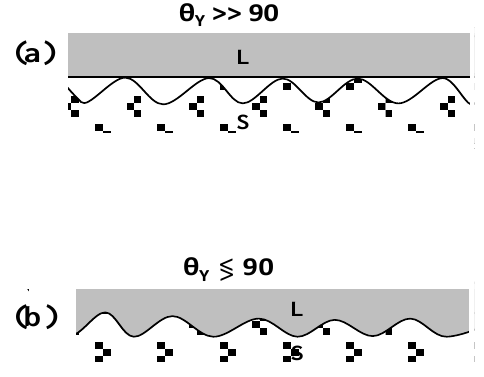
Figure 3. Microscopic configuration at solid/liquid interfaces: ( a ) For θ Y >> 90°, at microscopic scale, the liquid contacts the rough surface of the solid only at a few points. During cooling the solidified liquid detaches spontaneously from the solid; ( b ) For θ Y values lower than 90° or higher but close to this value, an intimate contact exists at any point of the interface.